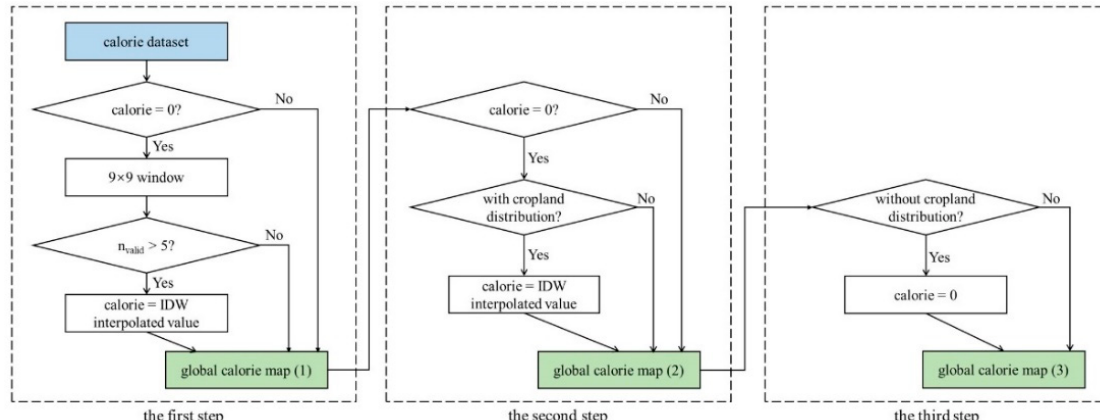
Figure 3. Flow chart of calculating calories of pixels. Blue represents input dataset. Green represents outputs in each step. Global calorie map (1) and global calorie map (2) are intermediate outputs to get global calorie map (3) which is useful in the next step. Here, n valid represents the number of pixels calorie distribution in a 9 × 9 window.